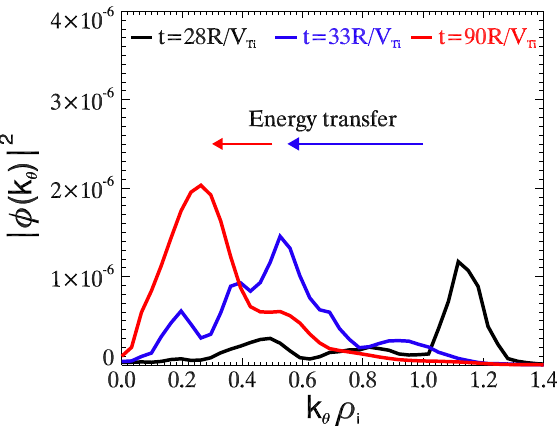
2 for three different time t φ( k θ ) | |